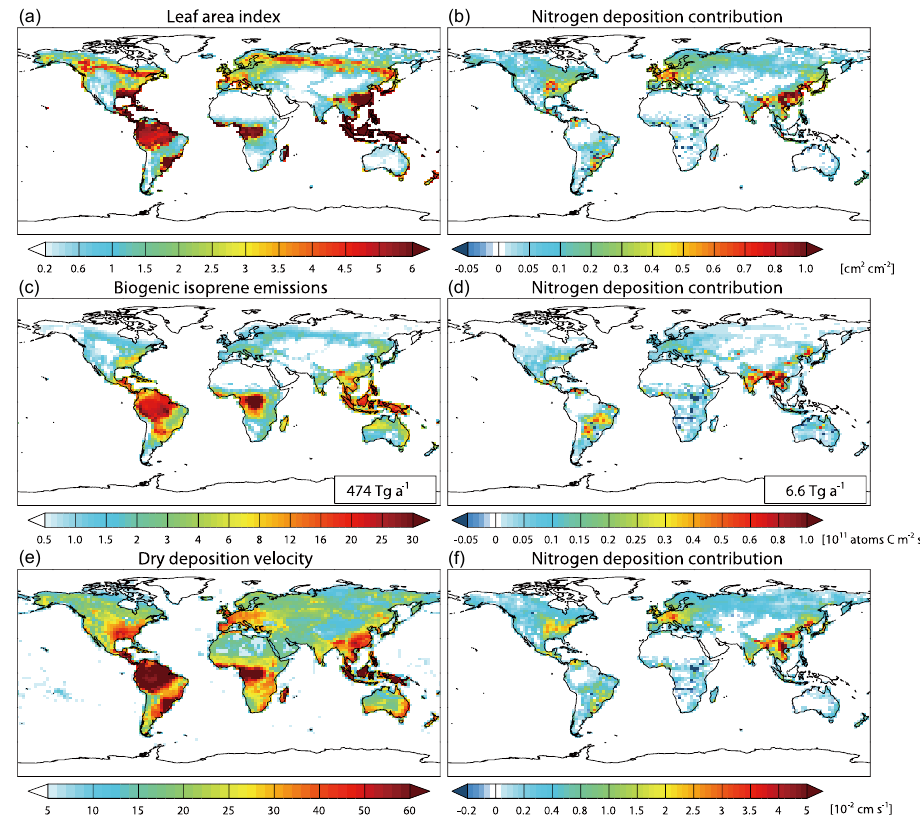
Figure 4. Leaf area index (a, b) , biogenic isoprene emission ( c, d with annual total emissions shown inset), and dry deposition velocity for ozone (e, f) as simulated by the asynchronously coupled modeling system. Panels (a) , (c) , and (e) represent the present-day conditions, and panels (b) , (d) , and (f) show perturbations as could be driven by human-induced atmospheric nitrogen